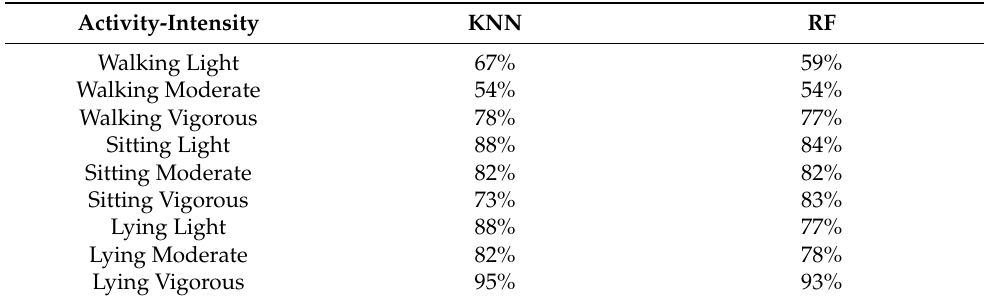
Table 2. KNN vs. Random Forest accuracy—Alternative 1.